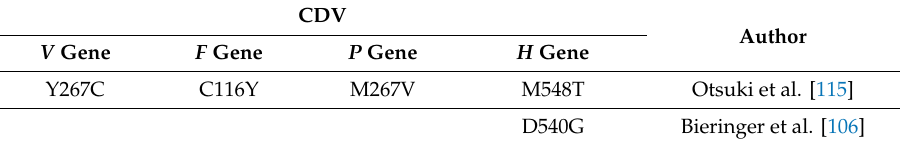
Table 1. Amino acid substitutions in the CDV H protein reported in strains adapted to human cell